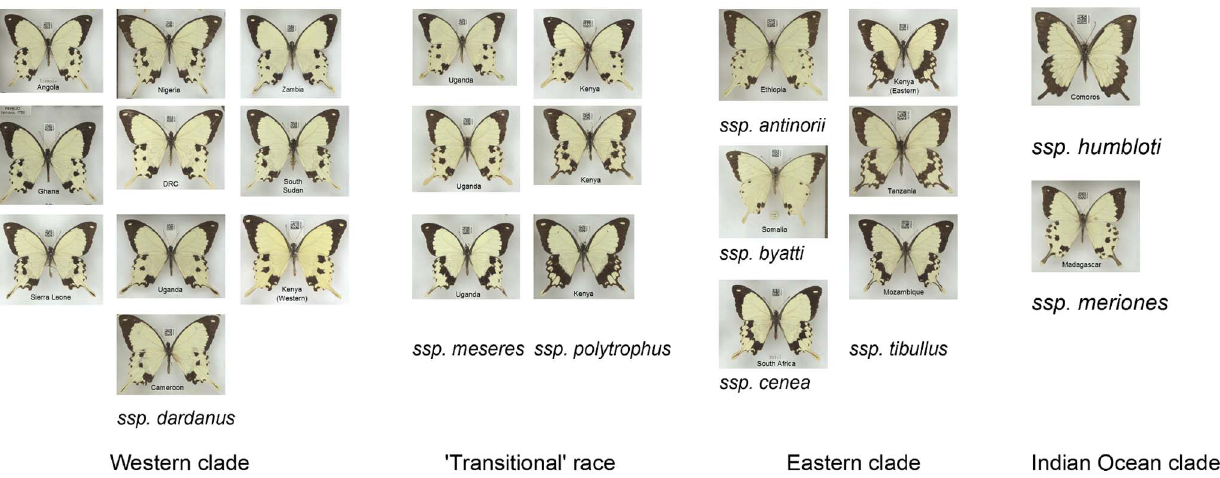
Figure 5. Typical male patterns for each of the subspecies of P.dardanus. Variation in male pattern was first used by Jordan [33] to divide P. dardanus into sub-species. The variability of pattern in the transitional subspecies meseres and subspecies polytrophus is noticeable.